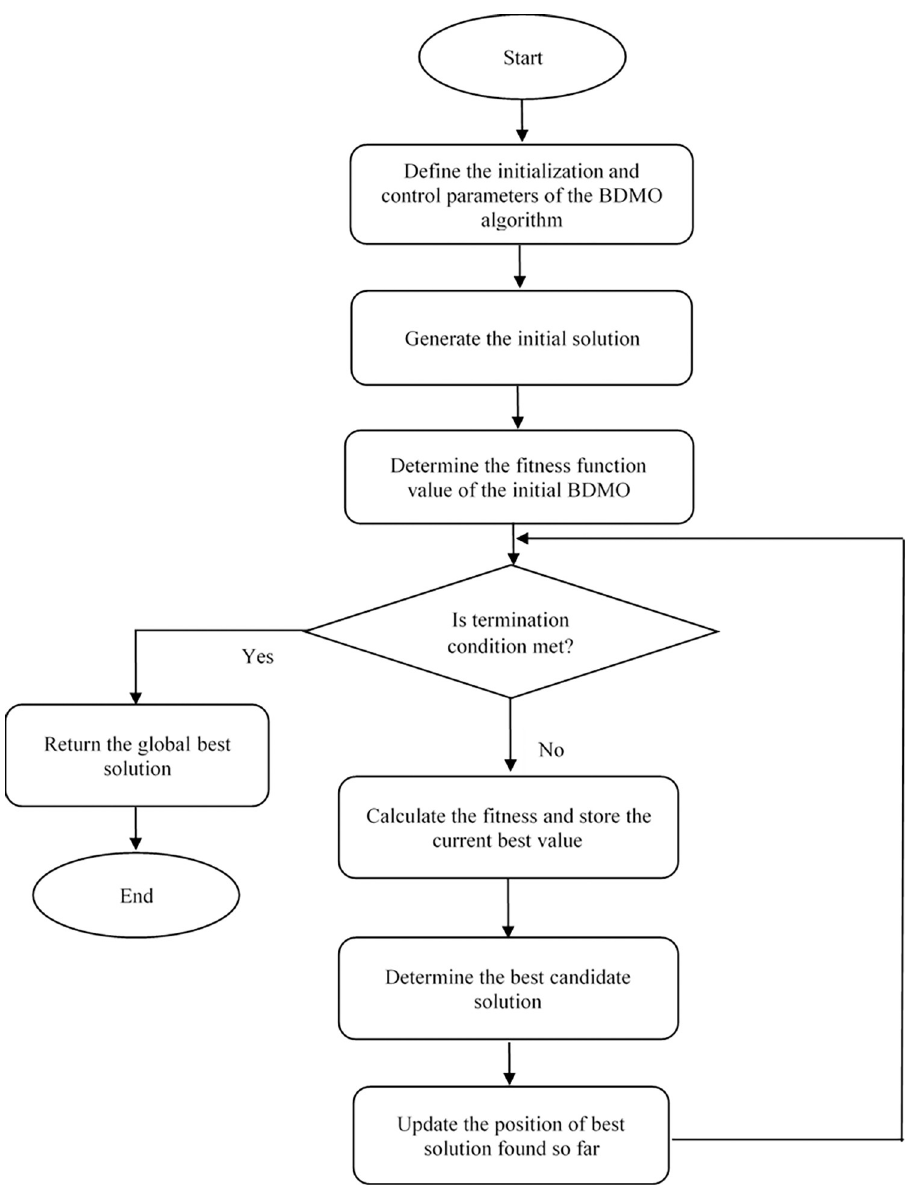
Fig 2. Flowchart depicting the structure of the BDMO